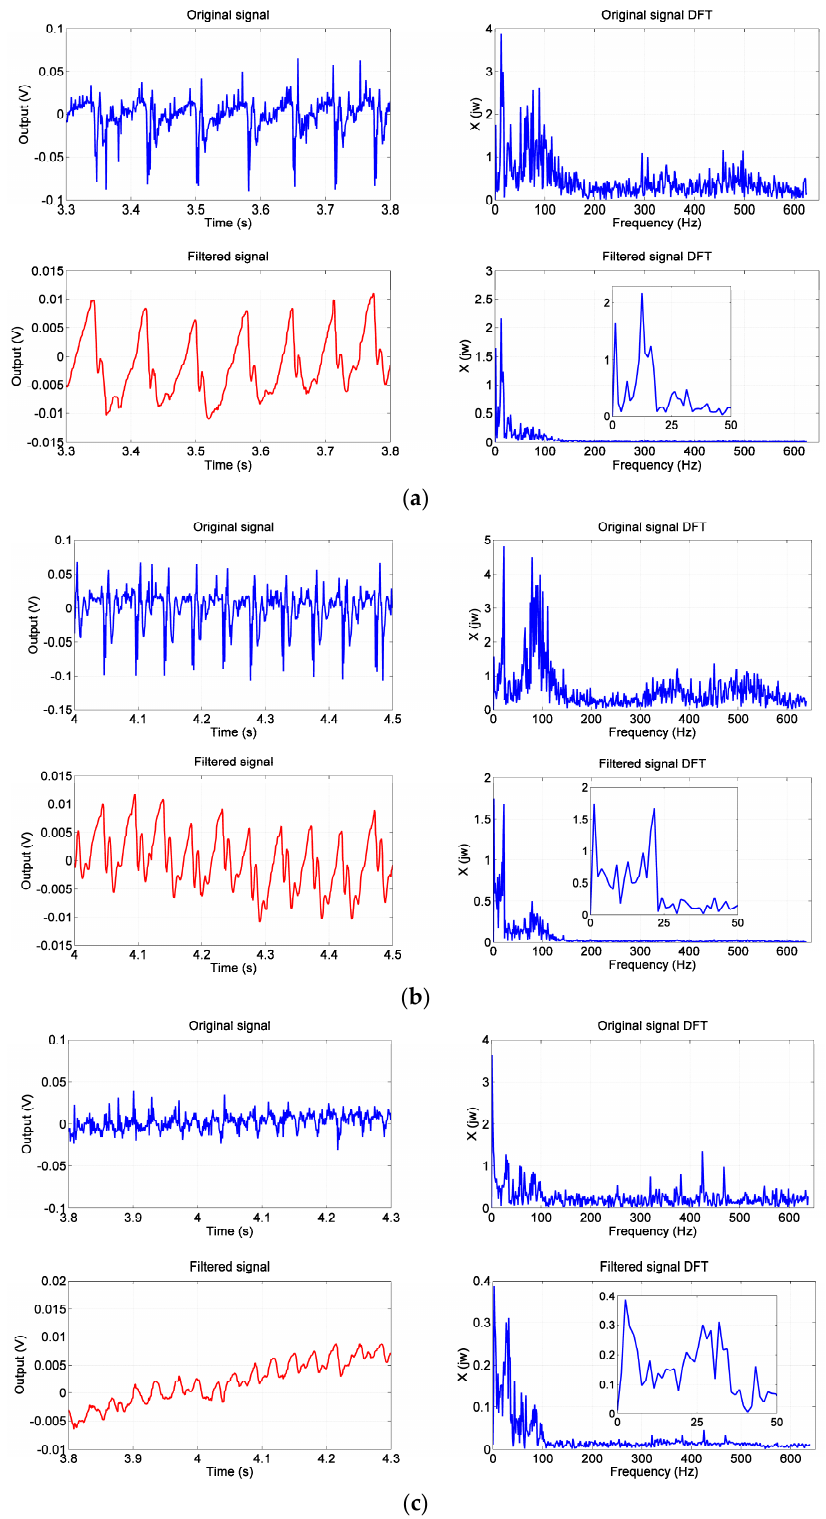
Figure 8. The results of surface with 4, 3 and 2 mm wide ridges, including the raw data, the result of Kalman filtering, the result of DFT and the result of both Kalman filtering and DFT. ( a ) the result of the surface with 4 mm wide ridges; ( b ) the result of the surface with 3 mm wide ridges; ( c ) the result of the surface with 2 mm wide ridges